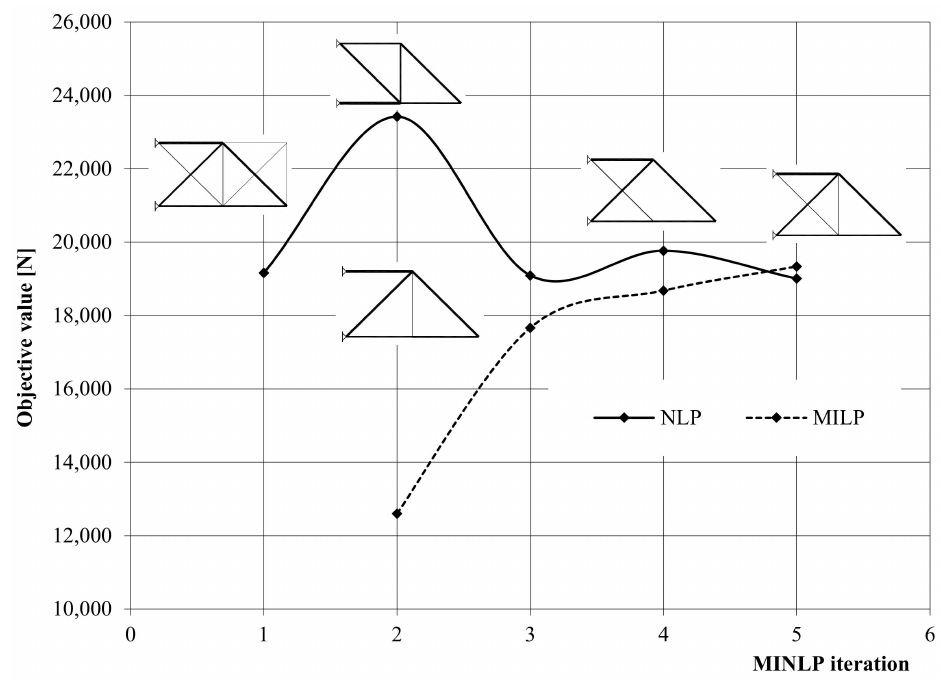
Figure 7. Convergence to the optimal topology, example TC10a (initial phase of the MTP strategy), example TC10a (topology optimization, without buckling